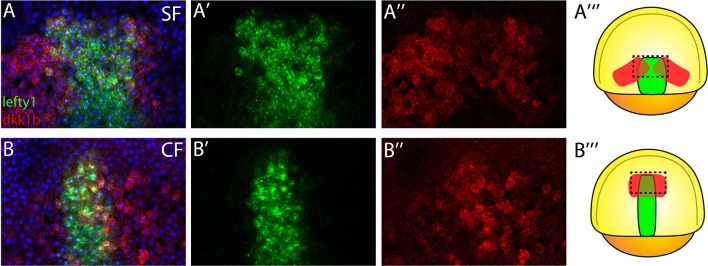
Expression of dkk1b and lefty1 during mid-gastrulation.Expression of dkk1b (red) and lefty1 (green) in surface fish (A) and cavefish (B) at 70% of epiboly.Scheme of surface fish (A’’’) and cavefish (B’’’) at 70% of epiboly with the region of interest indicated by a dashed box.